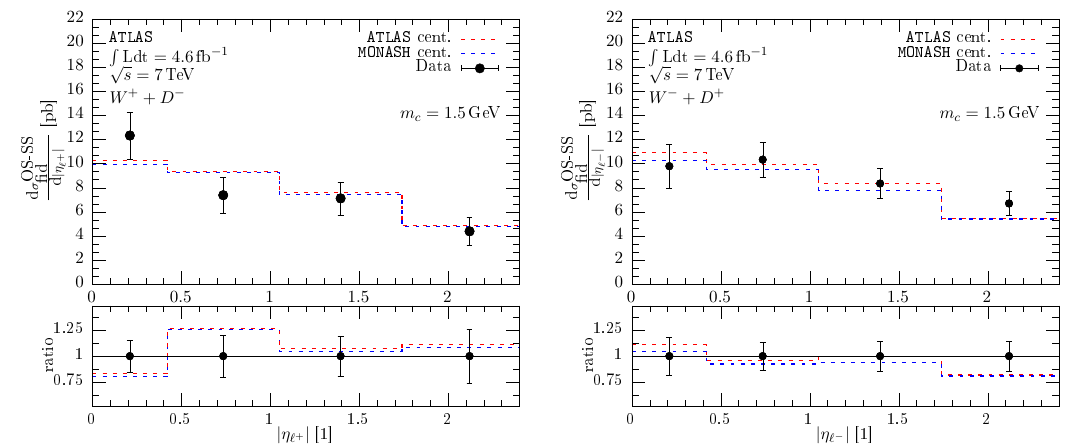
Figure 11 . Same as in figure 9 and 10, but limited to central predictions with two different PYTHIA8 tunes (Monash and ATLAS A14 central tune with NNPDF2.3LO